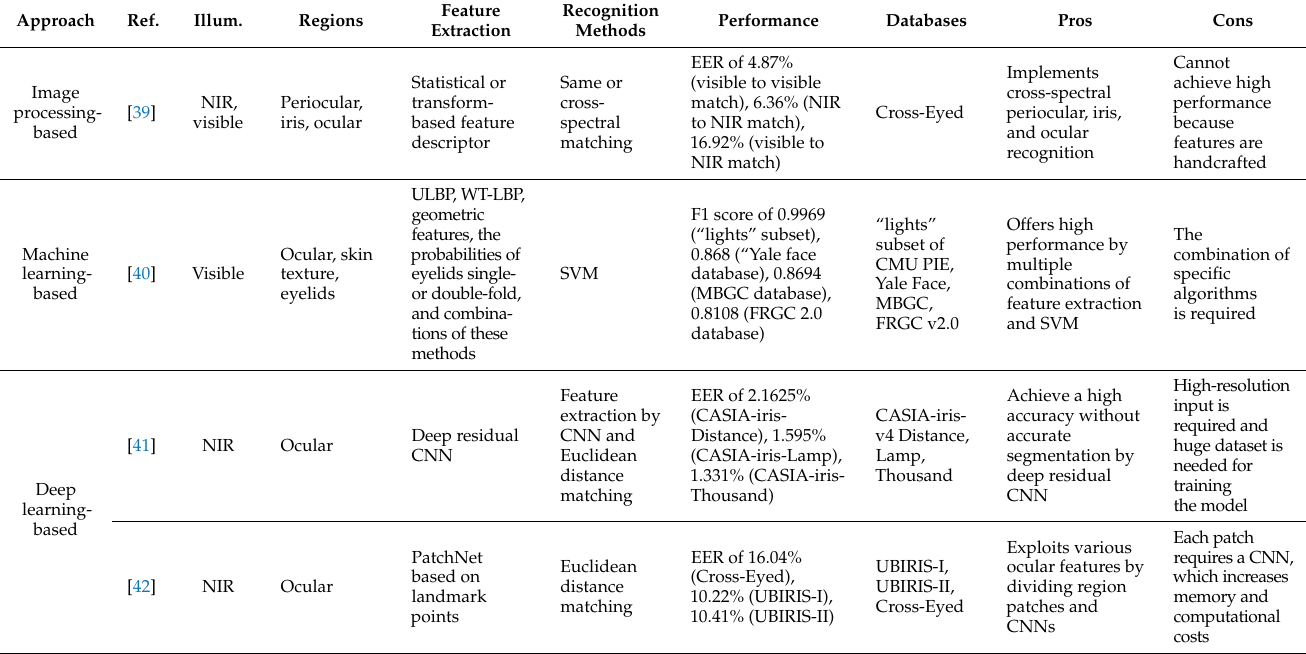
Table 2. Research of ocular recognition from high-resolution images (respectively, MBGC and FRGC denote the Multiple Biometrics Grand Challenge and Face Recognition Grand Challenge v2.0) (Ref. and Illum. denote reference and